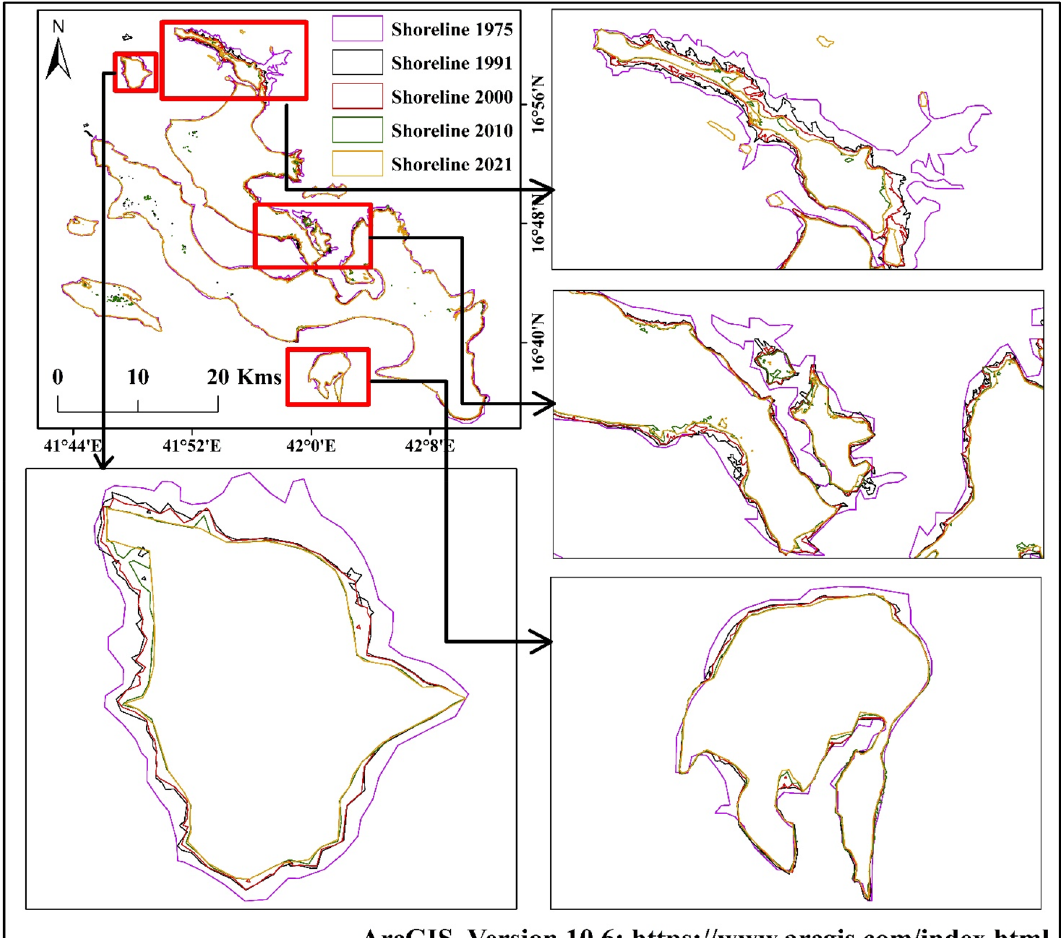
Figure 10. Shoreline shifting of Farasan Islands 31,64 . The satellite data was downloaded from USGS earth explorer (https:// earth explo rer. usgs. gov/). The map was generated using ArcGIS software, version 10.6 (https:// suppo rt. esri. com/ zh- cn/ produ cts/ deskt op/ arcgis- deskt op/ arcmap/